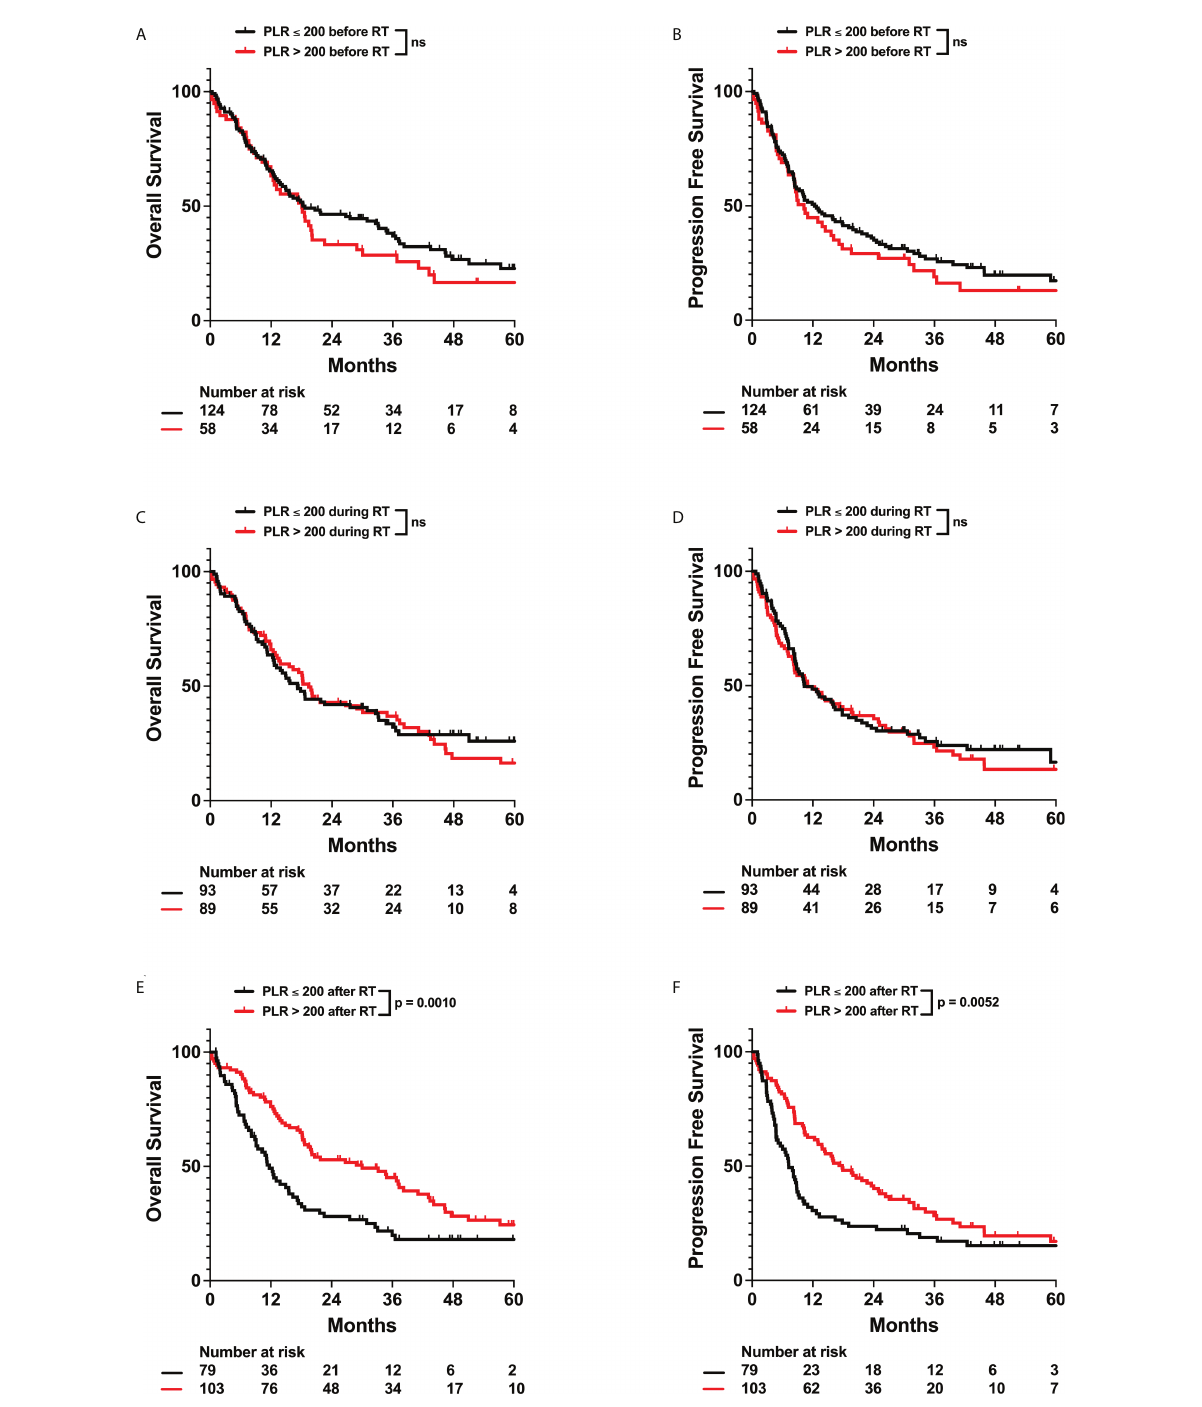
FIGURE 7 Effects of Platelet to Lymphocyte Ratio (PLR) on OS and PFS. Kaplan-Meyer plots of OS and PFS comparing patients with PLR > 200 (A, B) before, (C, D) during, (E, F) or after radiation treatment. Statistical analysis was performed using Cox Proportional Hazards tests. OS, Overall Survival; PFS, Progression Free Survival; PLR, Platelet to Lymphocyte Ratio; RT, Radiation therapy. ns, not signi fi